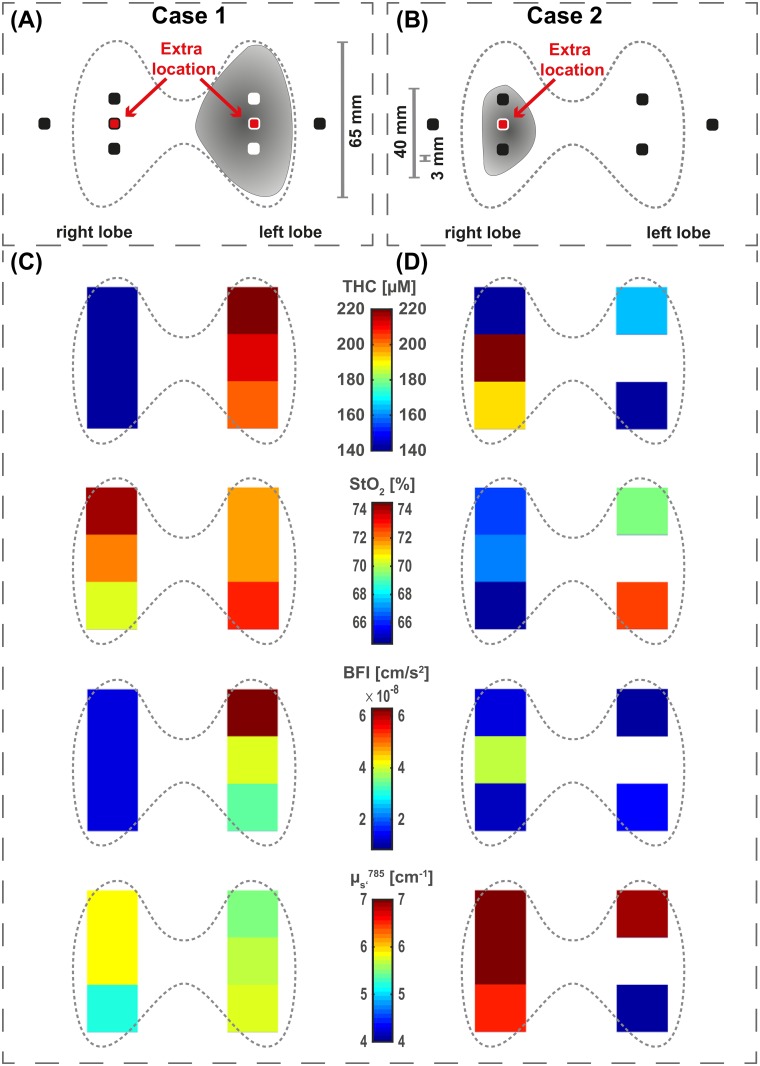
Thyroid schematics and results for the nodule cases.(A) CASE 1: Two locations were added to the standard protocol. The nodule was located within the left thyroid gland with a maximum diameter of 65 mm, as indicated by the shaded region. (B) CASE 1: One location was added on the right lobe to the standard protocol. This case had a maximum diameter 40 mm nodule (shaded region) together with a second nodule of 3 mm diameter, both located in the right thyroid gland. The results ((C) and (D)) are shown for the total hemoglobin concentration (THC), oxygen saturation (StO2), blood flow index (BFI) and the reduced scattering coefficient (μs′) for 785 nm. Note, that these color plots do not include the muscle locations. For the detailed representation please refer to the Tables in S4 Table and in S5 Table.